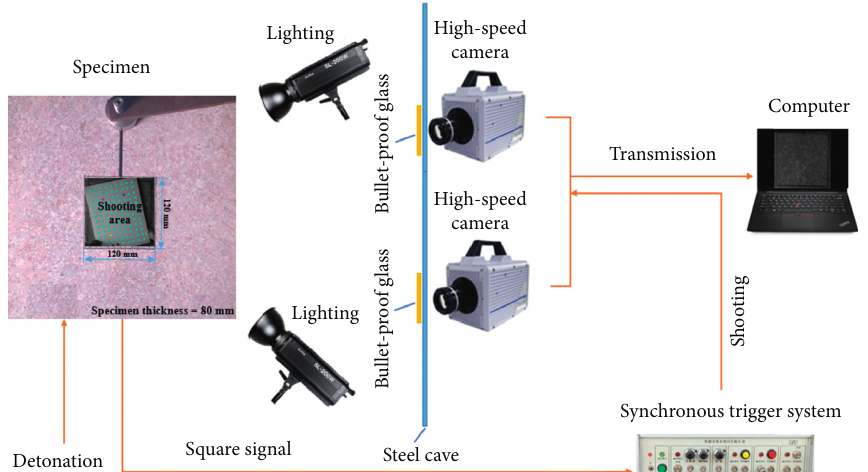
Figure 4: Schematic diagram of the experimental system.